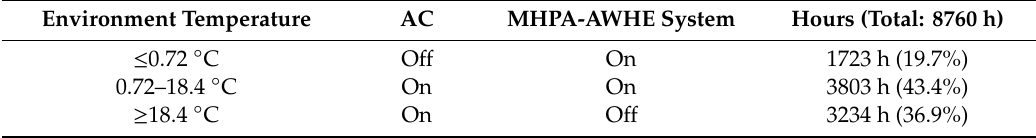
Figure 27. Annual hourly cooling capacity of DCs after the transformation. Table 5. Control strategy of equipment in DCs after the transformation.